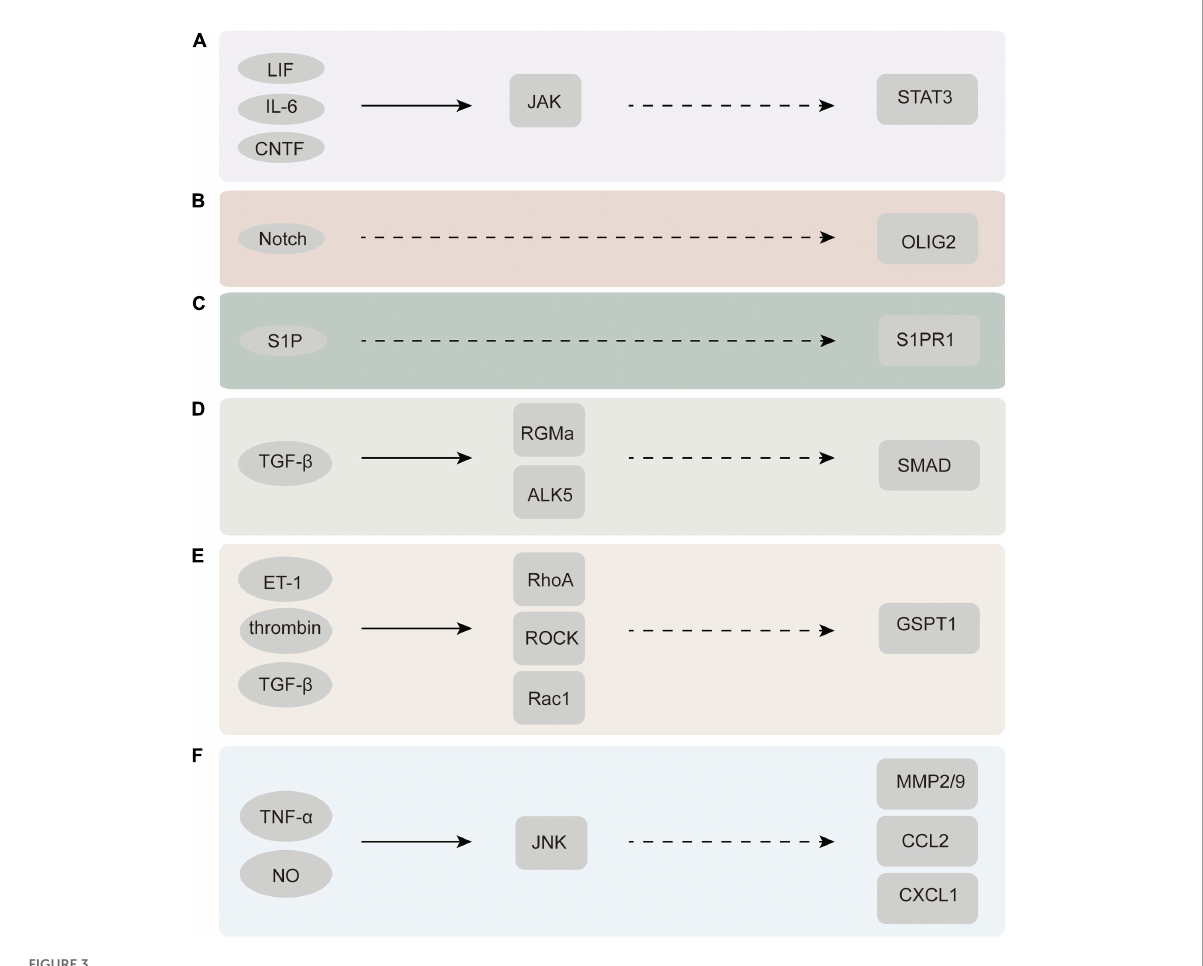
FIGURE3 Chemicals and molecules that activate astrocytes and their upstream and downstream signaling pathways. (A) JAK-STAT3 signaling pathway. (B) Notch-Olig2 signaling pathway. (C) S1PR1 signaling pathway. (D) TGF- β -SMAD signaling pathway. (E) Rac1-GSPT1 signaling pathway. (F) JNK signaling pathway. LIF, leukemia inhibitory factor; CNTF, ciliary neurotrophic factor; ET-1, endothelin-1; ROCK, rho associated kinase; GSPT1, G1 to S phase transition 1; JNK, C-Jun N-terminal kinase; MMP2/9, matrix